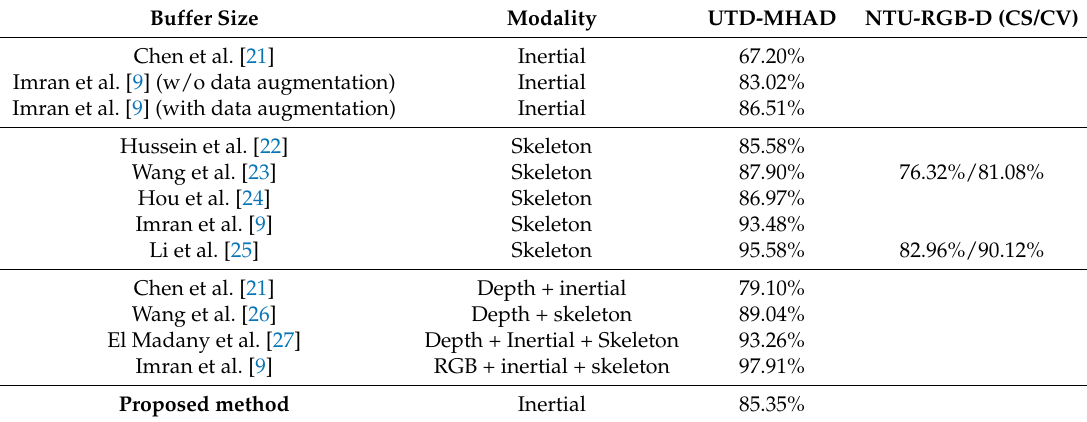
Table 3. Comparison with the literature. CS/CV, cross-subject/cross-view.